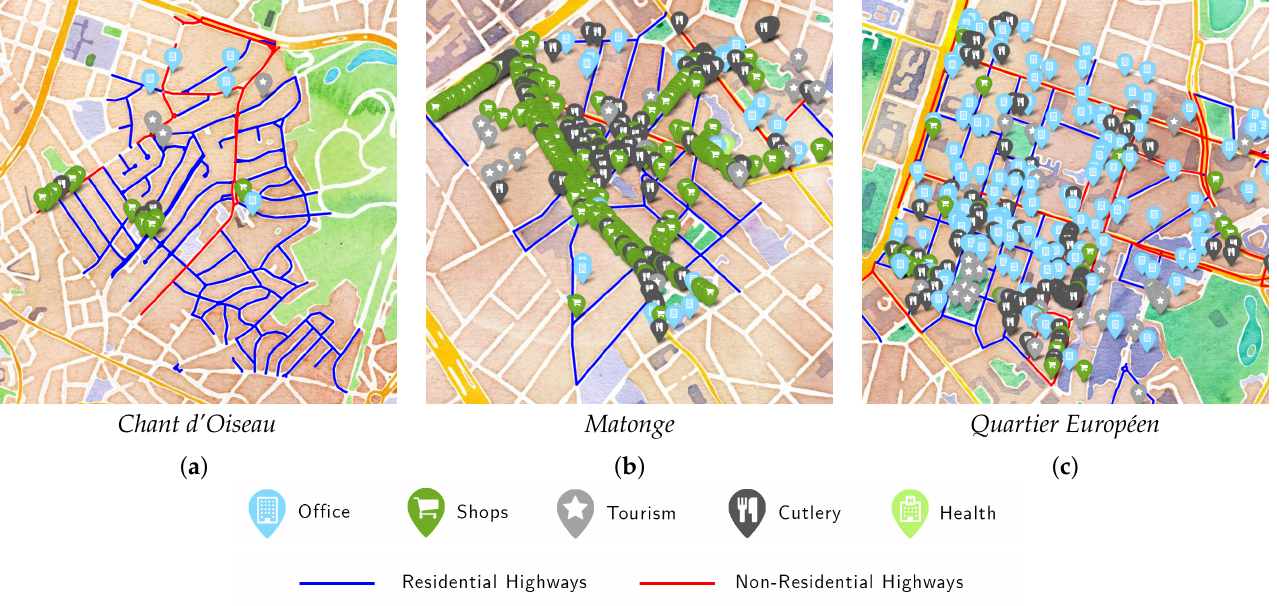
Figure 8. This figure shows three neighborhoods, each of them having a different nature. Their segmentation results are presented in Figure 7. All markers indicate a specific amenity extracted in OSM. ( a ) The map highlights Chant d’Oiseau , a heavily residential neighborhood, as shown by the numerous blue lines, testifying for the high proportion of housing. Regarding public amenities, it only accommodates a few shops. The PPR rate is relatively high due to the low parking